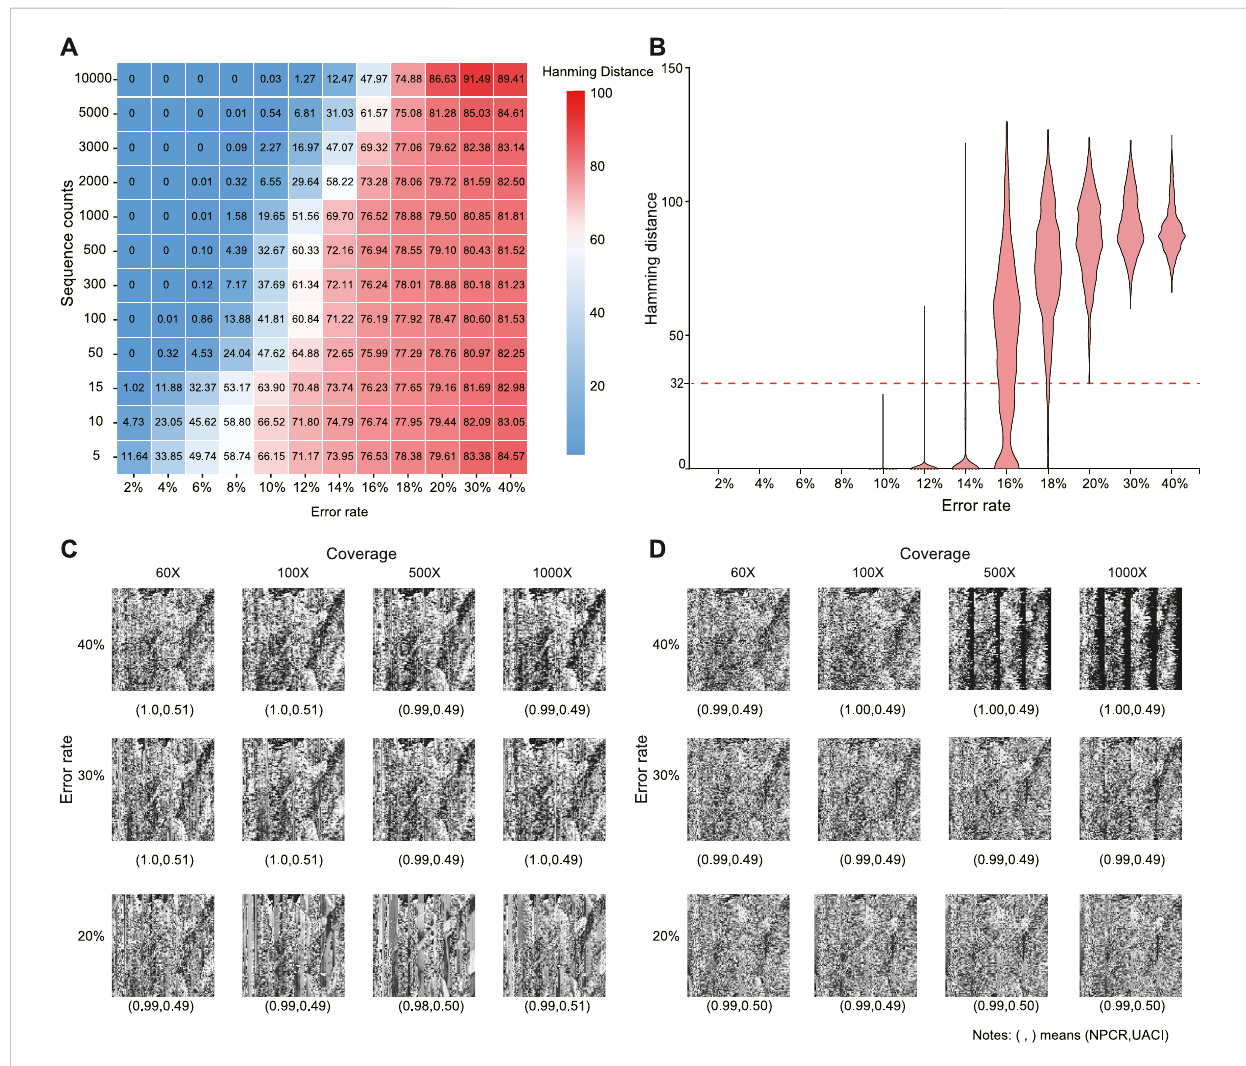
FIGURE 3 Cipher attack at different error rates and sequence copies. (A) Average Hamming distance between inferred and true modulation keys. (B) Distribution of Hamming distances of inferred modulation keys at sequence copies 10,000. (C) Decrypted images by inferred modulation keys. (D) Decrypted images by MSA. In (C) and (D) , the values in parentheses denote NPCR and UACI,